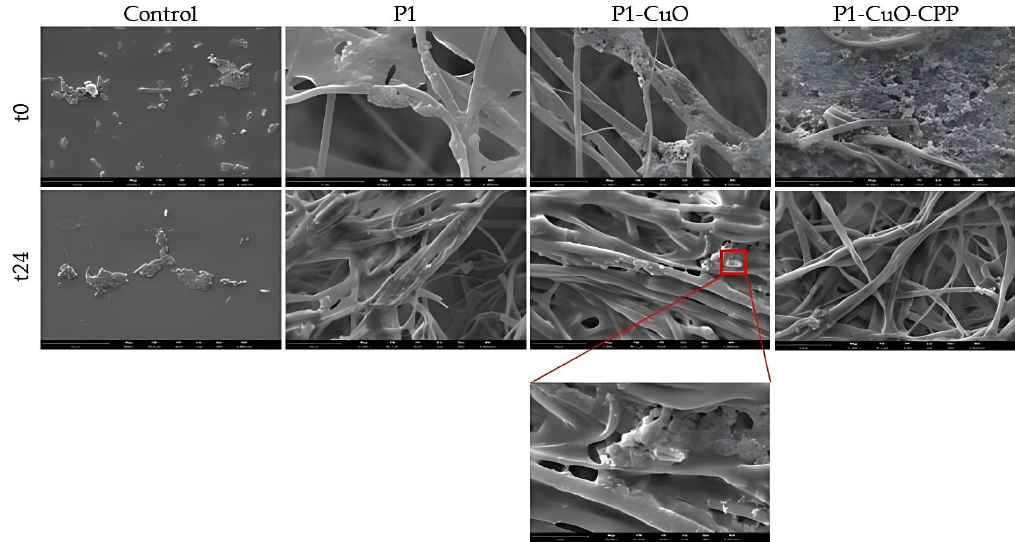
Figure 10. SEM micrographs of E. coli colonizing P1, P1-CuO, and P1-CuO-CPP scaffolds after 0 h of contact (t0) and 24 h of contact (t24). A glass slide was used as a control (mean values ± SD, n = 4) (scale bar = 15 µ